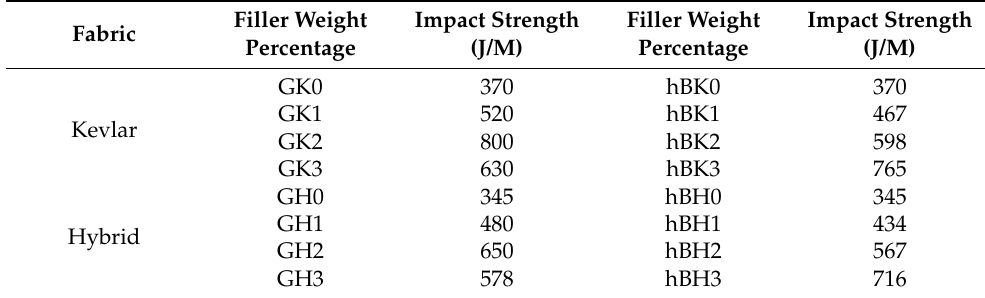
Table 8. Impact strength values of hBN-filled graphene